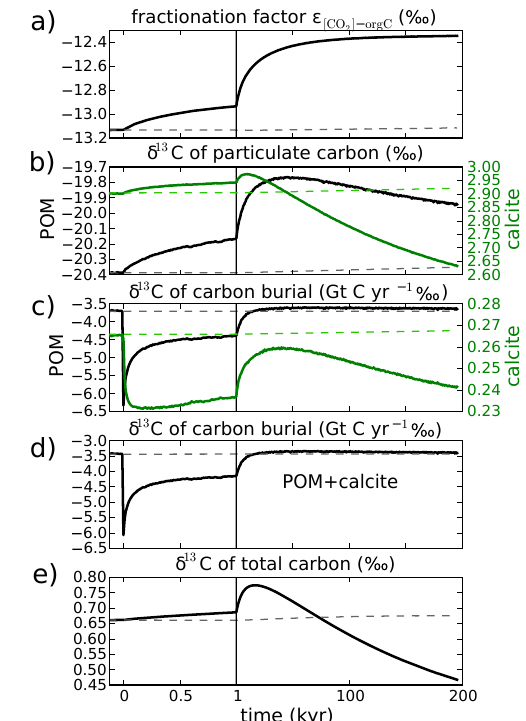
Figure 8. Time evolution of the oceanic 13 C budget. (a) Frac- tionation during organic C formation (photosynthesis) expressed as (cid:15) = 1000 · ( α − 1). (b) Isotopic signatures of particulate carbon in POM (black, left axis) and calcite (green, right axis). Burial of 13 C expressed as the C-burial flux times its isotopic signature in ‰ is shown in (c) for POM (black, left axis) and calcite (green, right axis), and for the total burial in (d) . (e) Average δ 13 C signature of the carbon in the atmosphere–ocean